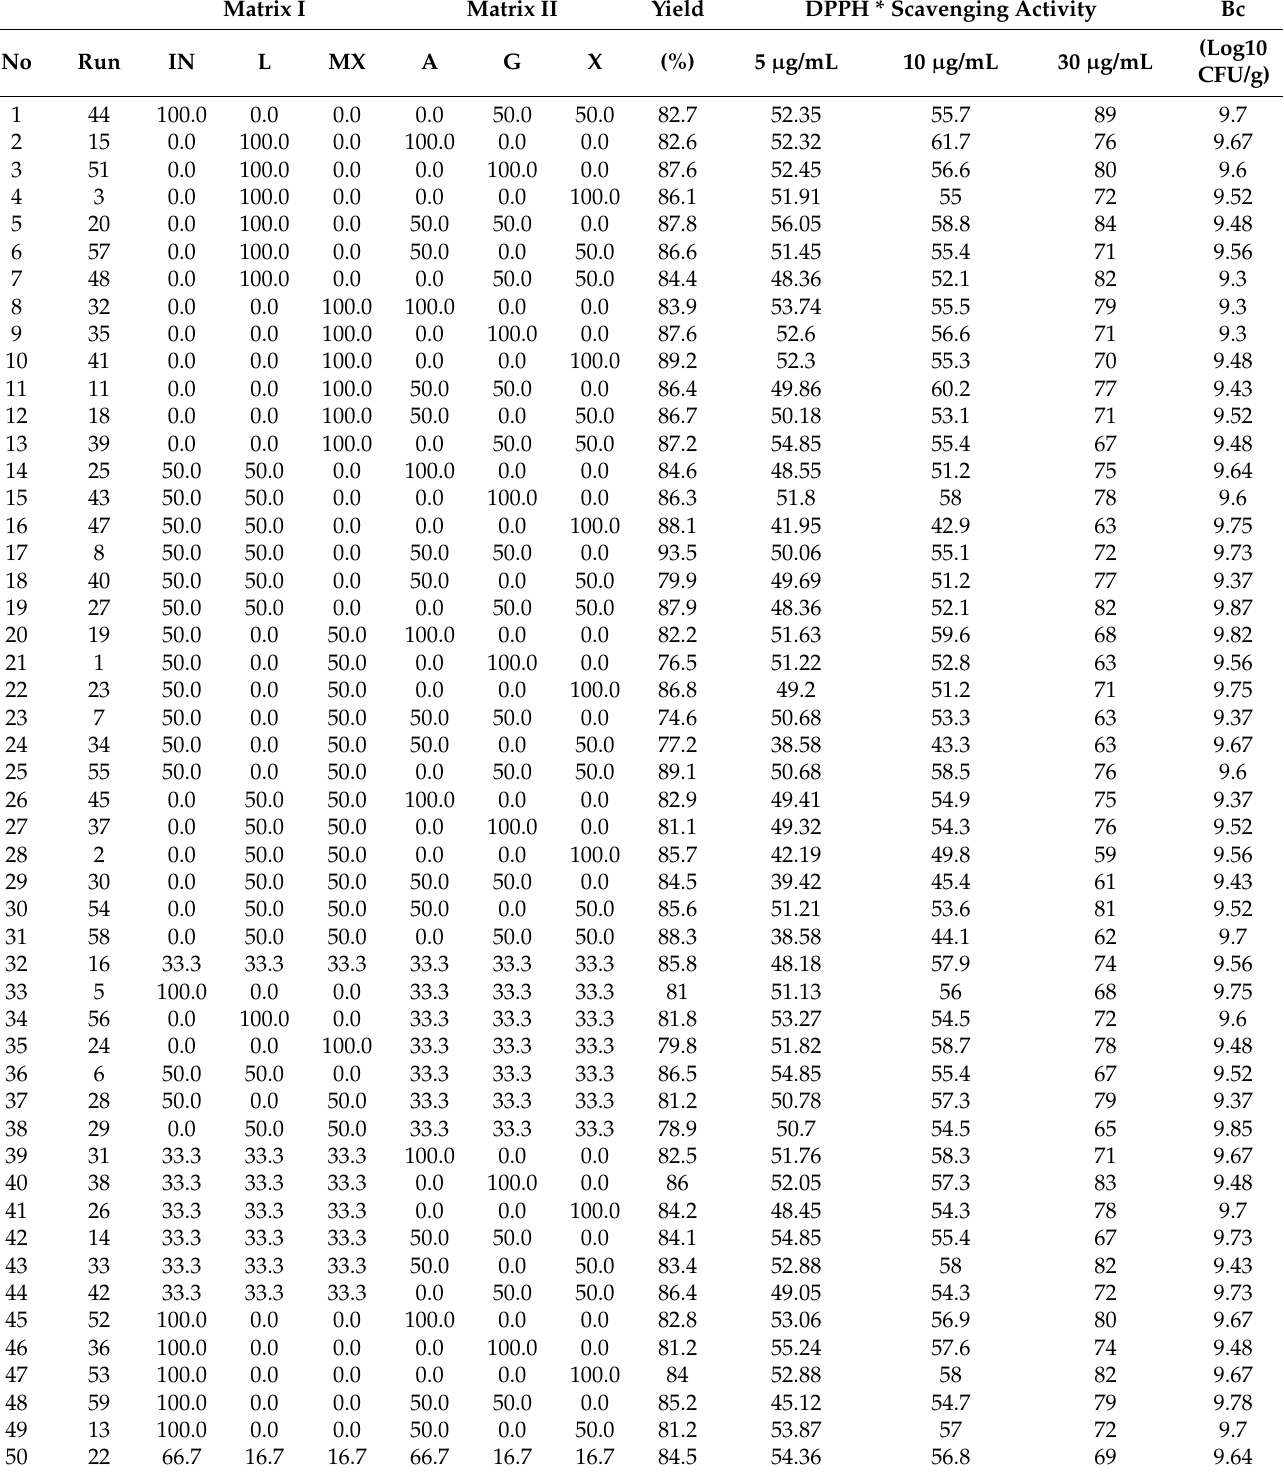
Table 1. Experimental design of two matrices for a special cubic x special cubic